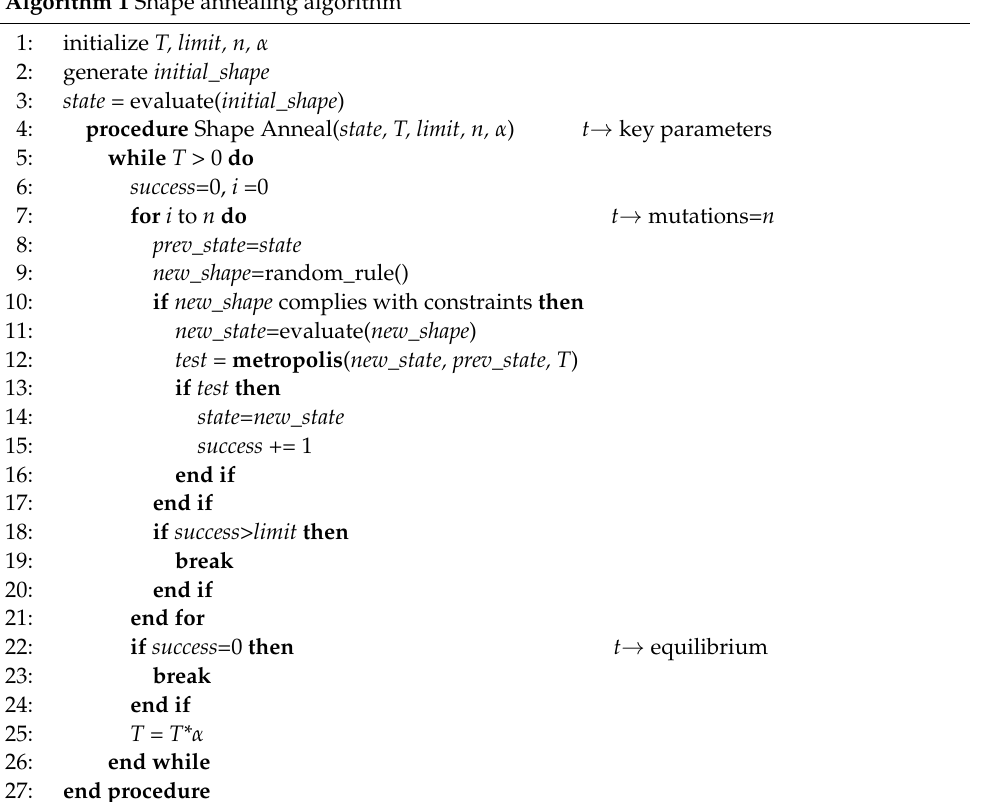
Algorithm 1 Shape annealing